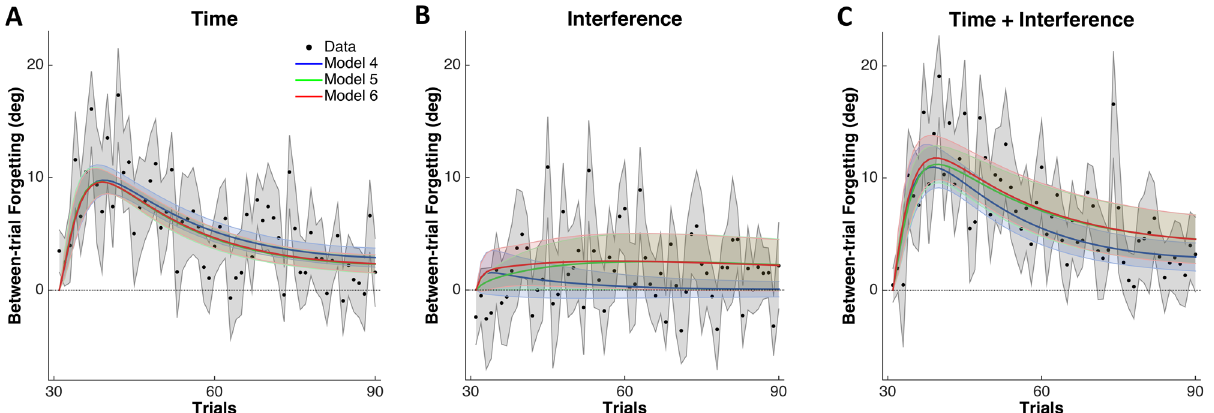
Fig 4. Estimated effects of time and/or interference on between-trial forgetting with data and predictions from the three selected models. A : Time effect as the difference in training performance between SHORT-ITI and LONG-ITI. B : Interference effect as the difference in training performance between and LONG-ITI and ALT. C : Combined effect of time and interference as the difference in training performance between SHORT-ITI and ALT. Black: data, blue: model 4 (two interfering fast processes and two independent slow processes), green: model 5 (two independent fast processes and two interfering slow processes), red: model 6 (two interfering fast processes and two interfering slow processes). Dots and lines indicate the means, shaded areas indicate the ± S.D. from 10,000 bootstrapped samples.